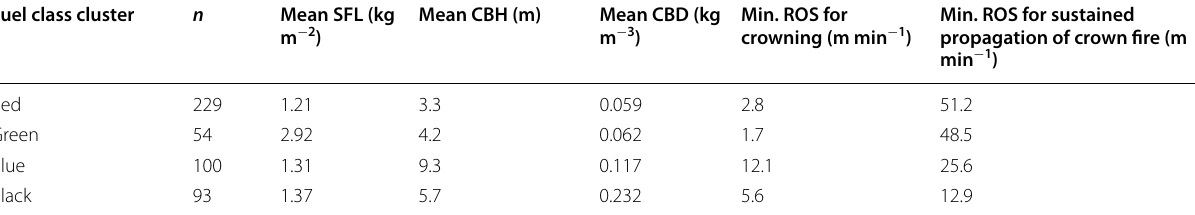
Table 1 Mean values for surface fuel load (SFL), live canopy base height (CBH), and canopy bulk density (CBD) by fuel class cluster (FCC) and the corresponding minimum rate of spread (ROS) for crowning and sustained propagation of a crown fire Fuel class